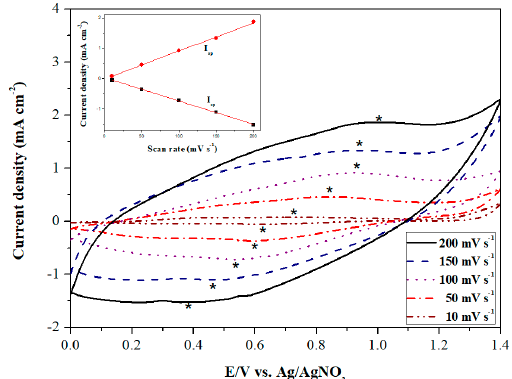
Figure 4. Cyclic voltammograms (CV) curves of the P(dCz2- co -dTC2) film at different scan rates between 10 and 200 mV s − 1 in the LiClO 4 / ACN / DCM solution. Inset is scan rate dependence of the P(dCz2- co -dTC2) anodic and cathodic peak current densities.